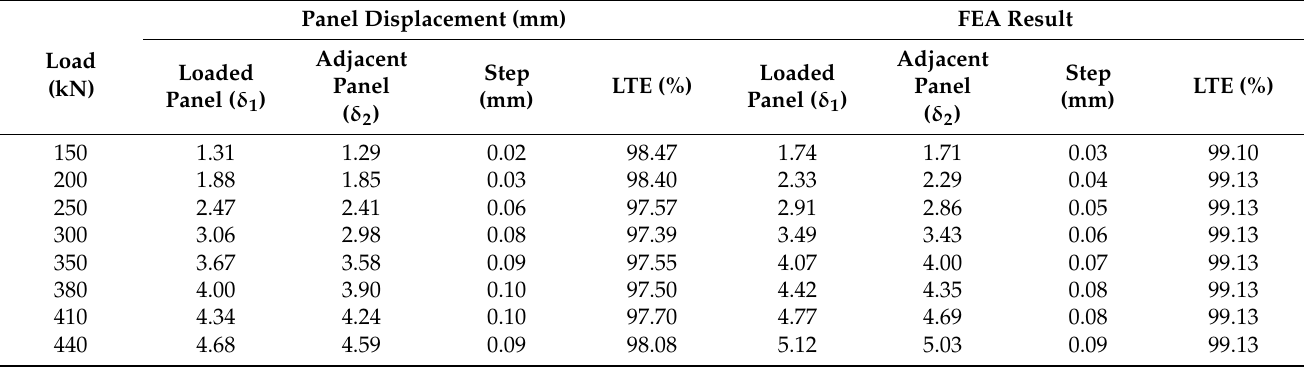
Table 7. Load transfer efficiency (LTE) of panel between panel endpoint and panel adjacent (Load at 2nd panel 4/4 loading point).